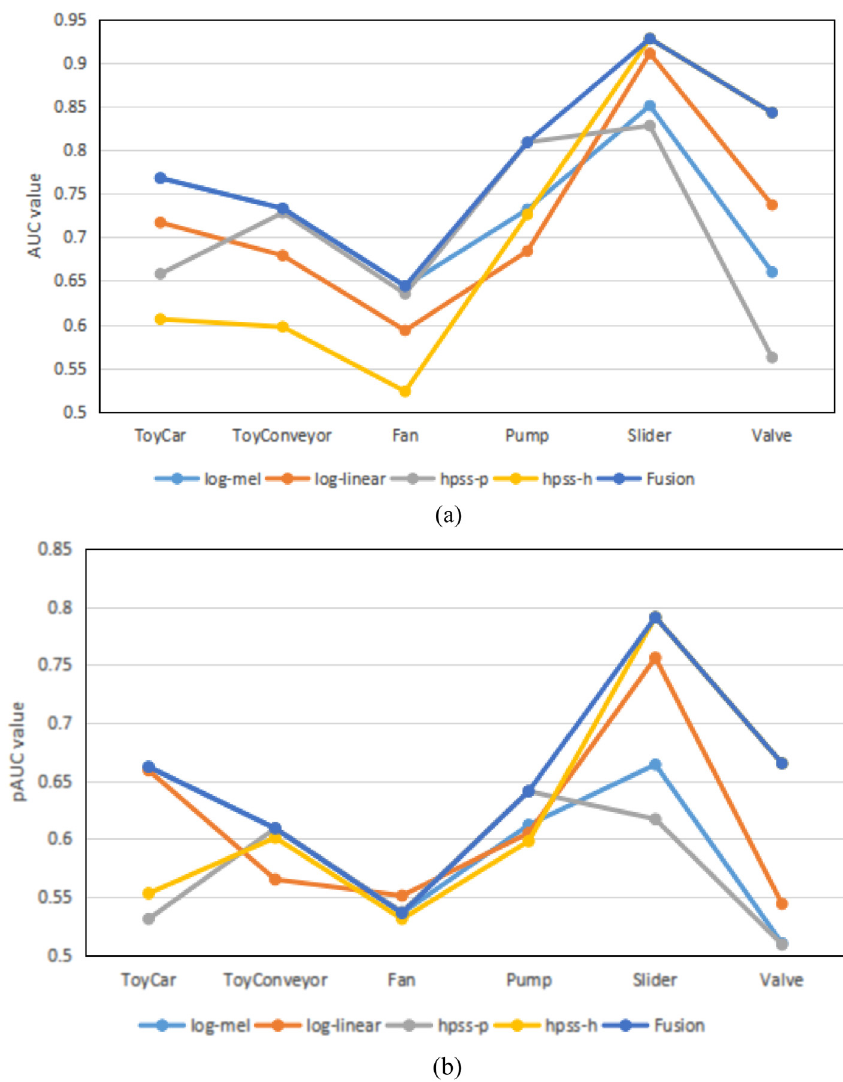
Fig. 8. Comparison line chart of each model: (a) line chart of AUC value; (b) line chart of pAUC